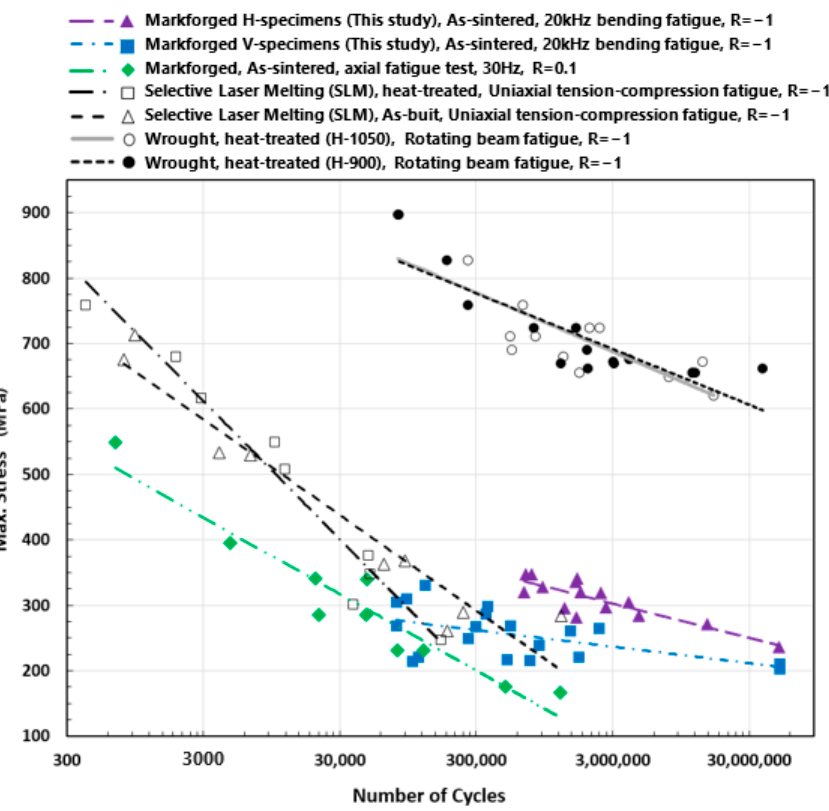
Figure 18. Comparing the stress–life data of a 17-4 PH SS test specimen made of wrought material [35] (rotating-beam fatigue test) with those of test specimens fabricated using Markforged BPE (HF bending-fatigue test, as used in this study, and axial fatigue test [36]) and SLM (uniaxial tension– compression fatigue test)